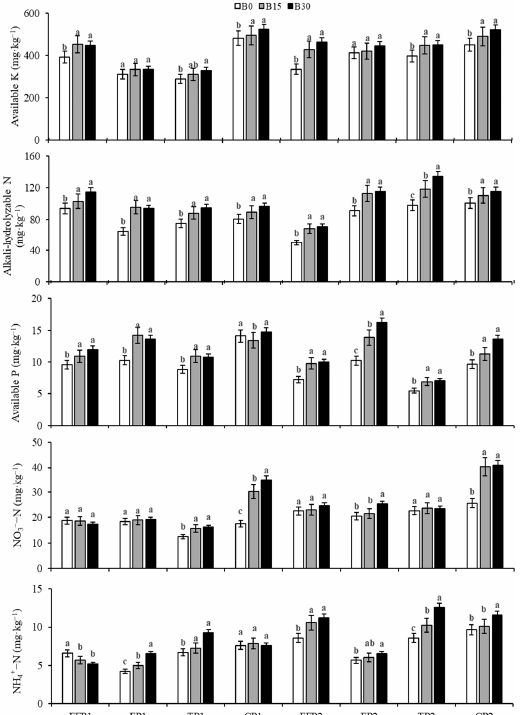
Figure 1. Variation in soil nutrients under biochar treatment during various phases of the study period (Note: Different lowercase letters represent a significant difference between treatments at p < 0.05).